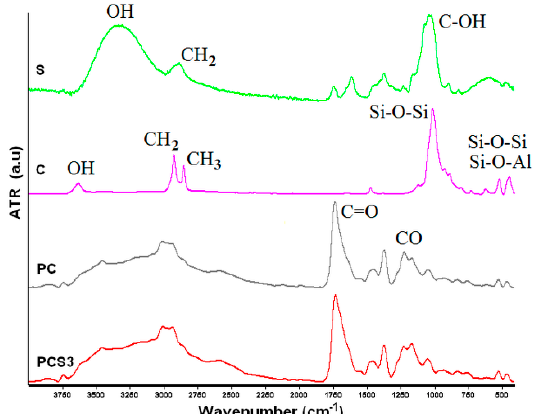
Figure 3. FTIR spectra of clay-C, Salecan-S and composite hydrogels without-PC Salecan and with Salecan-PCS3.